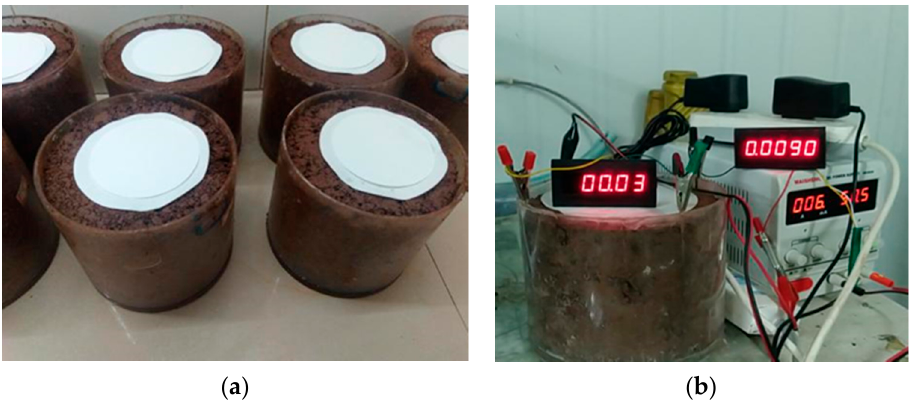
Figure 3. Sandstone specimen. ( a ) Substrate suction test; ( b ) electrical resistivity test.